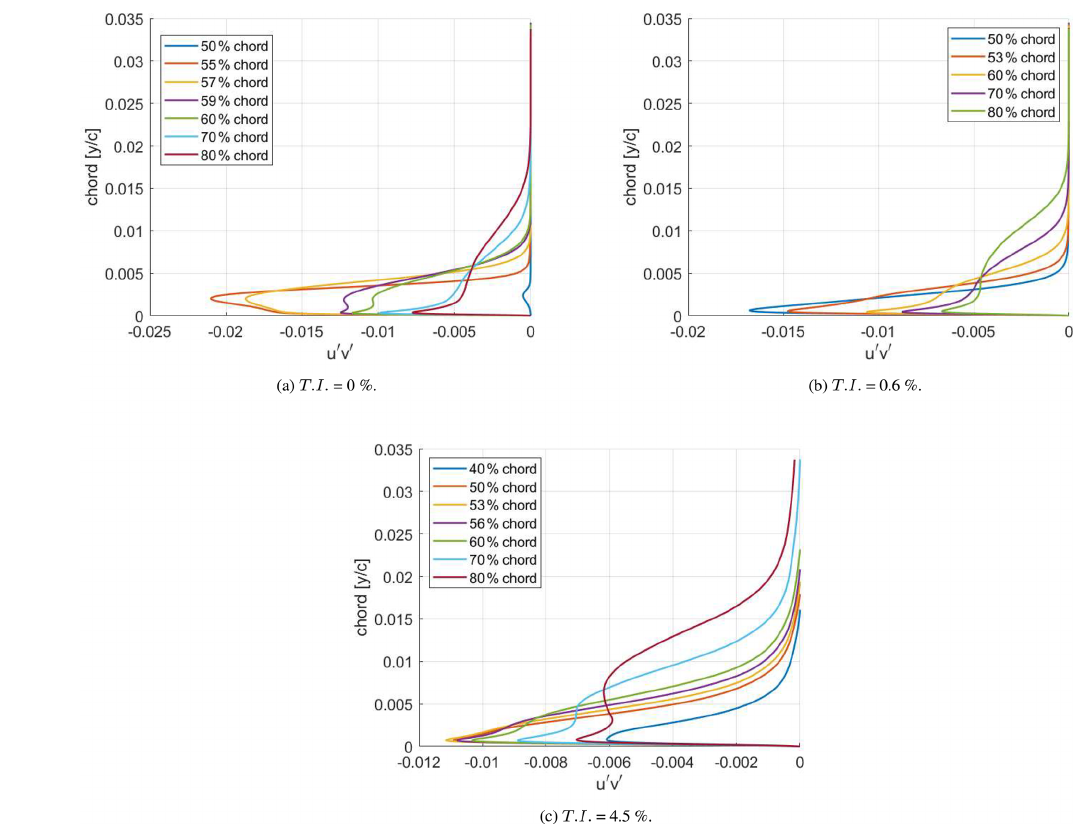
Figure 20. Distribution of the Reynolds shear stress u (cid:48) v (cid:48) in the wall-normal direction at selected chord